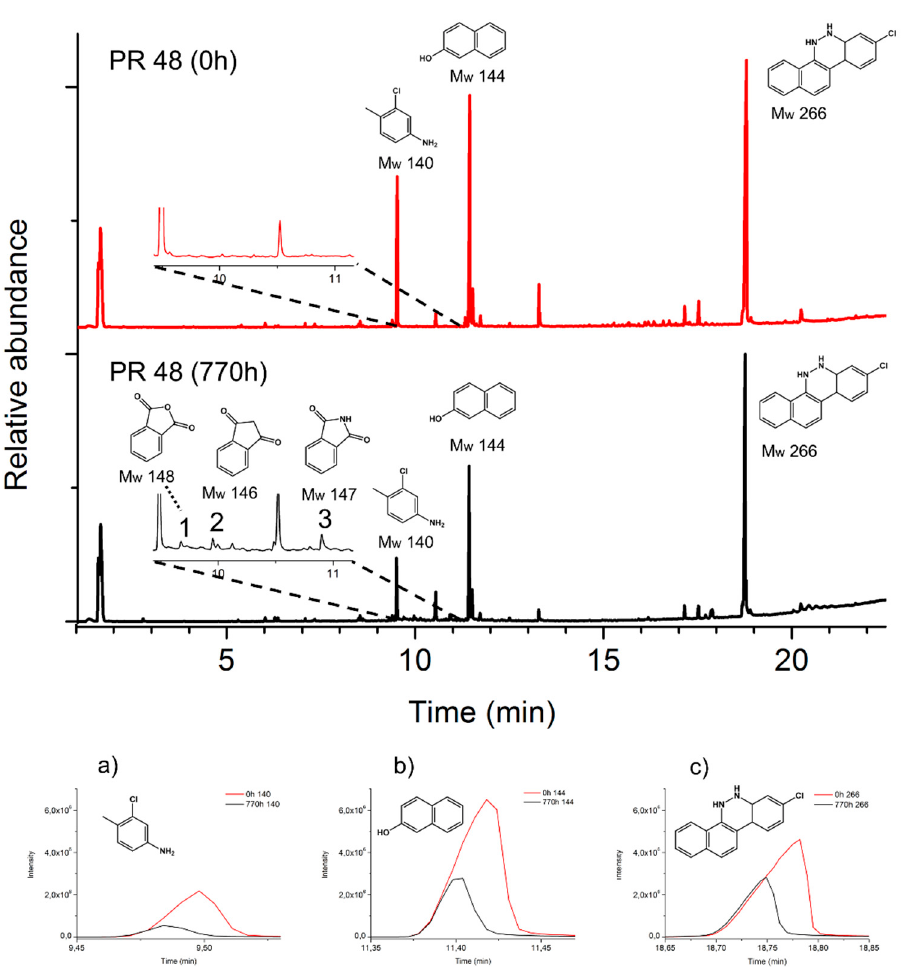
Figure 6. Top: normalized pyrograms of the red powder pigment PR 48:2. At 0 h, the main pyrolysis structures (M w 140, M w 144, and M w 266) are observed; after aging (770 h), decay products (M w 148, M w 146, and M w 147) are formed (Table 1). Bottom ( a – c ): principal extracted ions (base peaks) of the main pyrolysis products.